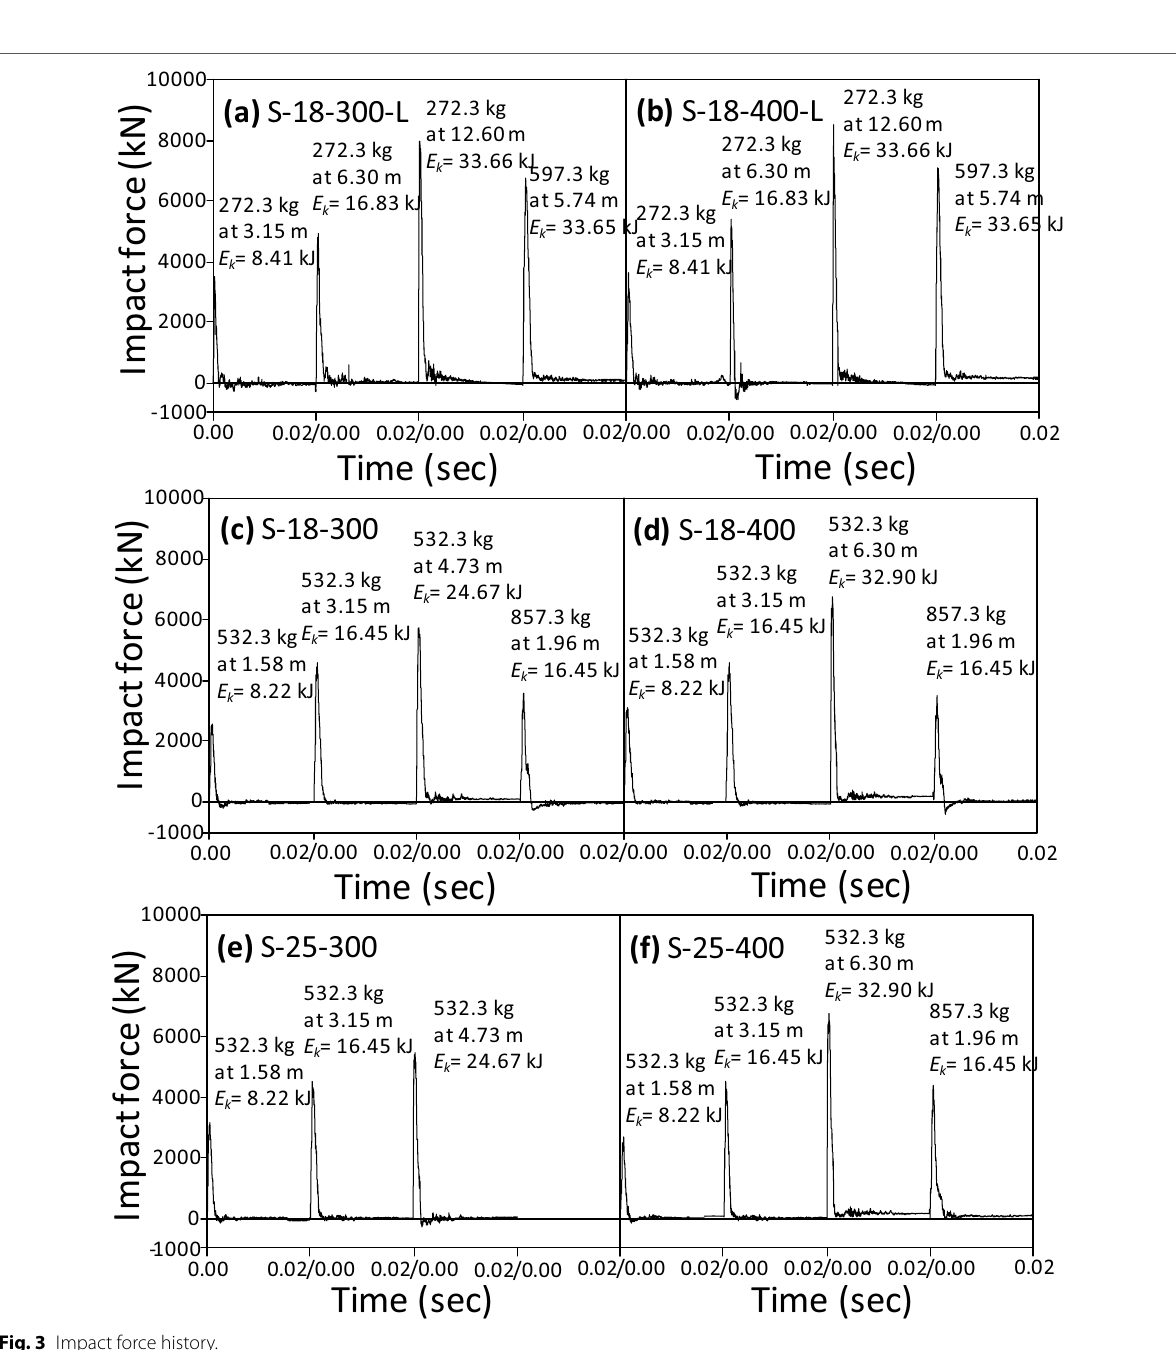
Fig. 3 Impact force